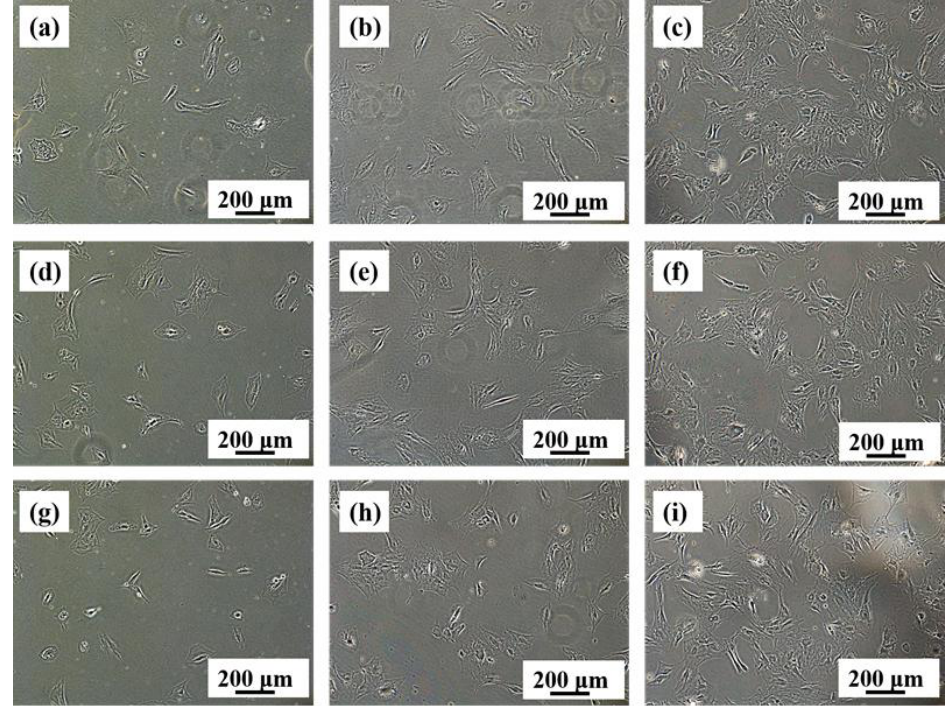
Figure 10. The number and morphology of MC3T3-E1 cells cultured with extracts of Ti-28Nb-35.4Zr